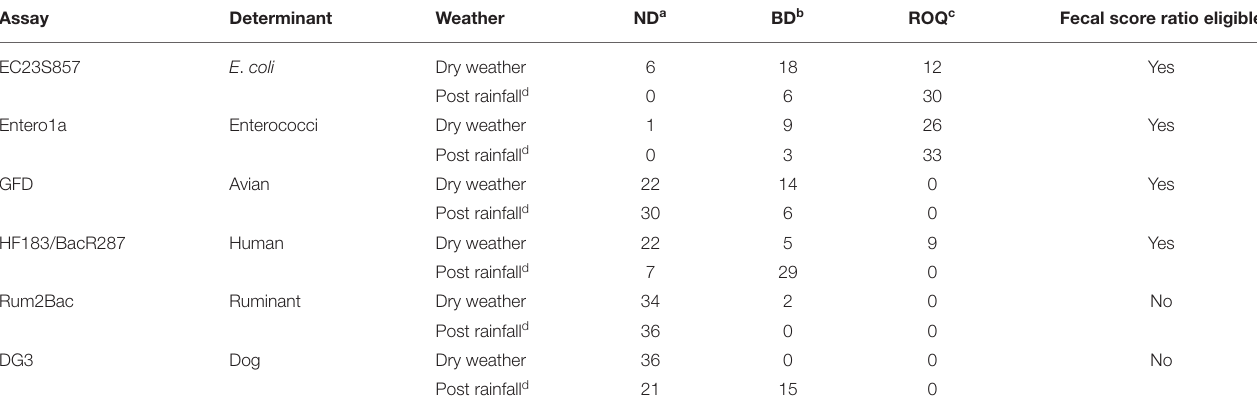
TABLE 1 | Enumeration using qPCR. Assay Determinant Weather ND a BD b EC23S857